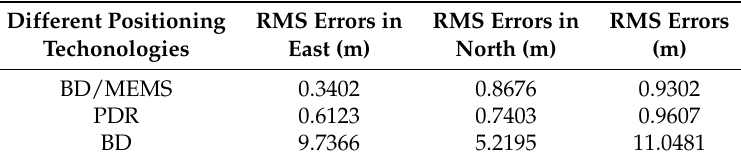
Table 4. Comparison of positioning errors.